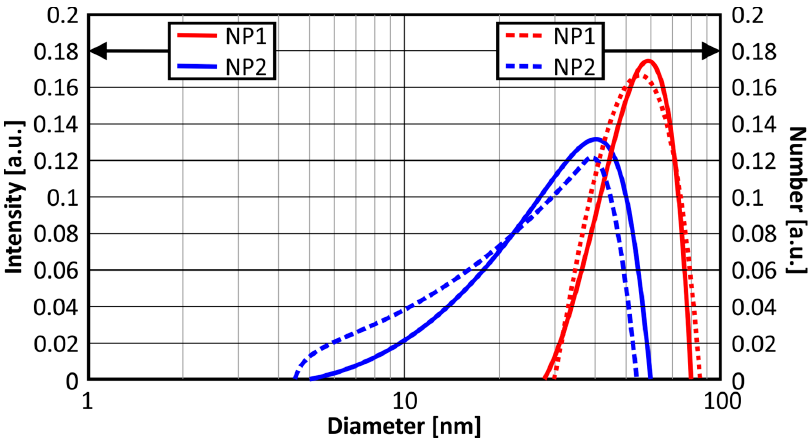
Figure 2. Dynamic light scattering results for both AgNPs variations NP1 and NP2.